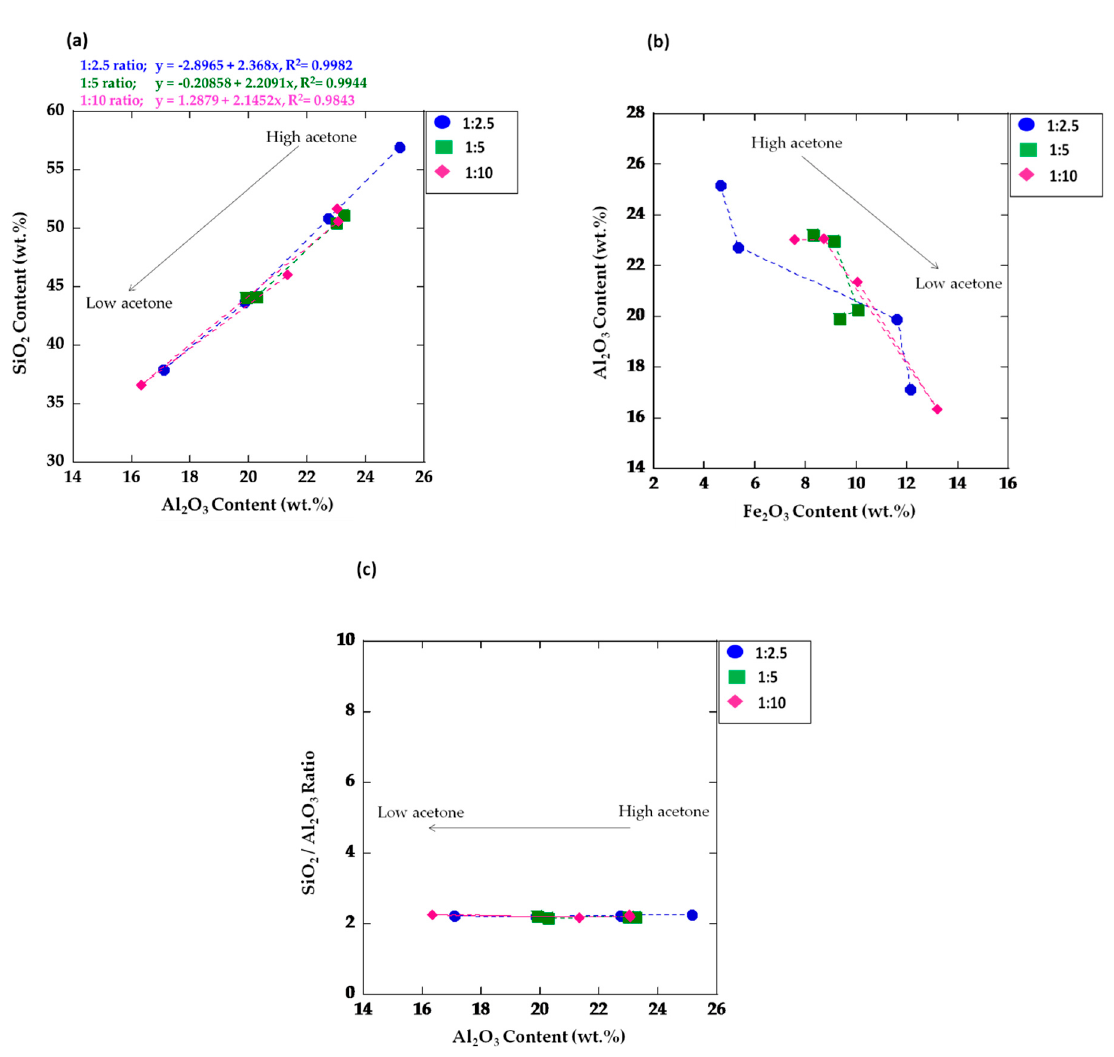
Figure 6. Dependence of ( a ) SiO 2 and Al 2 O 3 contents, ( b ) Fe 2 O 3 and Al 2 O 3 , and ( c ) the SiO 2 /Al 2 O 3 ratio and Al 2 O 3 content. The data were taken from Table 3.